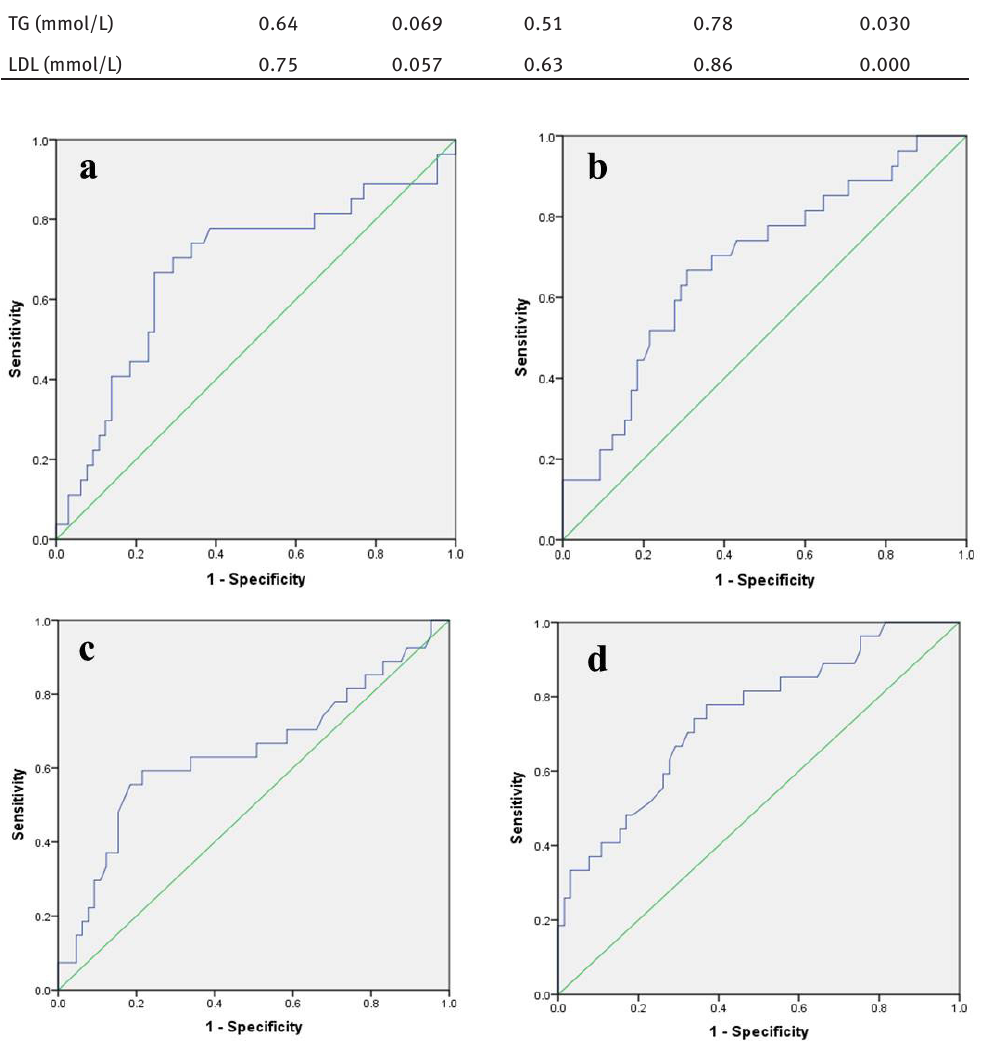
Figure 1. ROC curve of serum neopterin, Hcy TG and LDL as biomarker for predicting the risk of developing IS in patients with TIA (a: serum neopterin; b: serum Hcy; c: serum TG; d:serum